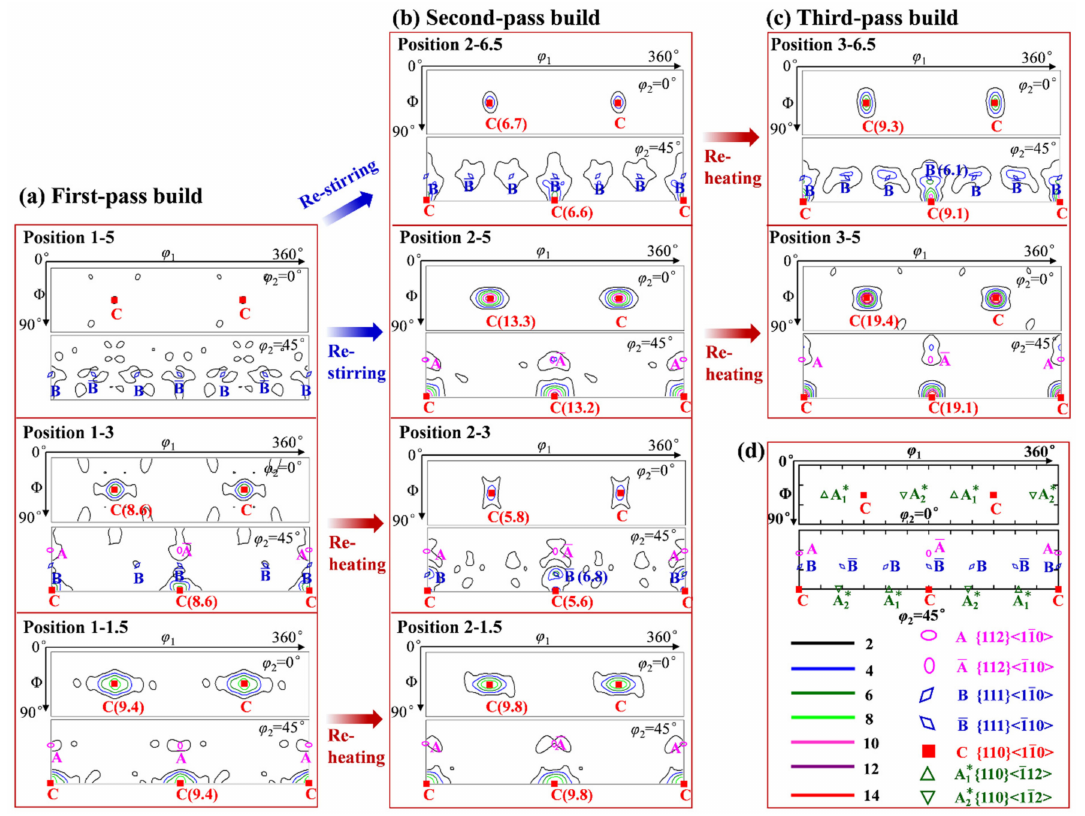
Figure 7. ϕ 2 = 0 ◦ and ϕ 2 = 45 ◦ sections of orientation distribution function (ODF) in different regions of the ( a ) first-, ( b ) second-, and ( c ) third-pass builds; ( d ) ideal orientations of face-centered cubic metals under simple shear in the ϕ 2 = 0 ◦ and ϕ 2 = 45 ◦ ODF sections [47]. The specified positions of the ODFs are shown in Figure 3a–c, marked with red dots.